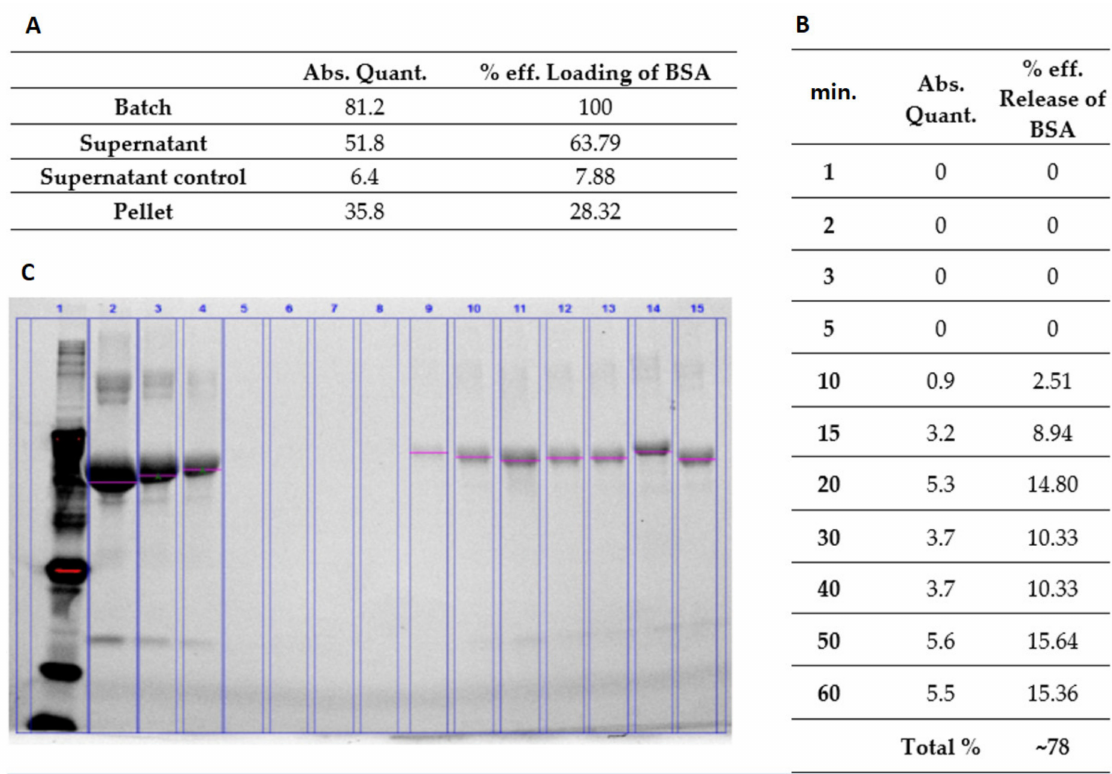
Figure 4. ( A ) Quantification of cargo loading. ( B ) Quantification of cargo release at the appropriate time points. ( C ) Elec- trophoresis of BSA model-protein in prestained gradient gel. Molecular weight markers are in lane 1 and standard concentrations of 100, 80, and 50 µ g/mL of BSA in lanes 2–4. Lanes 5–15 represent BSA released in time periods at 1, 2, 3, 5, 10, 15, 20, 30, 40, 50, and 60 min,